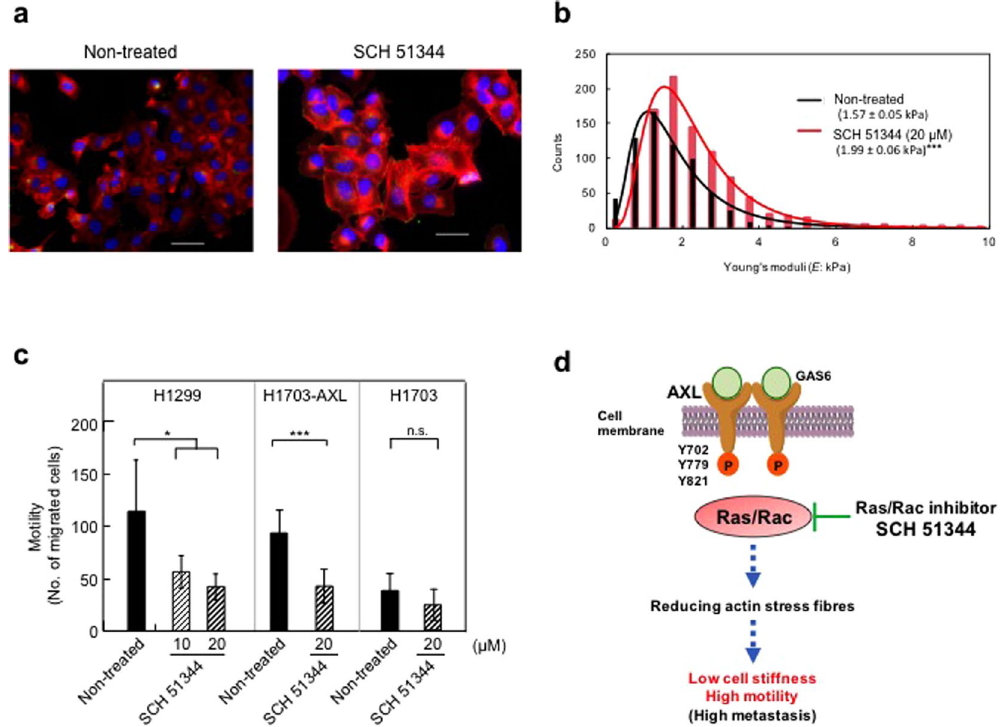
Figure 6. SCH 51344, a Ras/Rac pathway inhibitor, inhibits motility and increases actin stress fibres and cell stiffness in H1299 and H1703-AXL cells. ( a ) Actin stress fibres formation (red) in non-treated H1299 cells and cells treated with 20 μ M SCH 51344 for 4 h. ( b ) Young’s moduli of 60 cells in non-treated and SCH51344-treated H1299 cells measured using AFM. Black line indicates the log-normal fitting curve for non-treated H1299 cells, and the red line is the curve for SCH51344-treated H1299 cells. *** p < 0.001. ( c ) Cell motility in H1299 cells and H1703 cells treated with SCH51344. Average number of migrated cells in three independent experiments. Mean ± s.d. * p < 0.05, *** p < 0.001. ( d ) Schematic illustration of the mechanism of stimulation of motility and cell softening by activation of AXL, mediated through the Ras/Rac pathway.